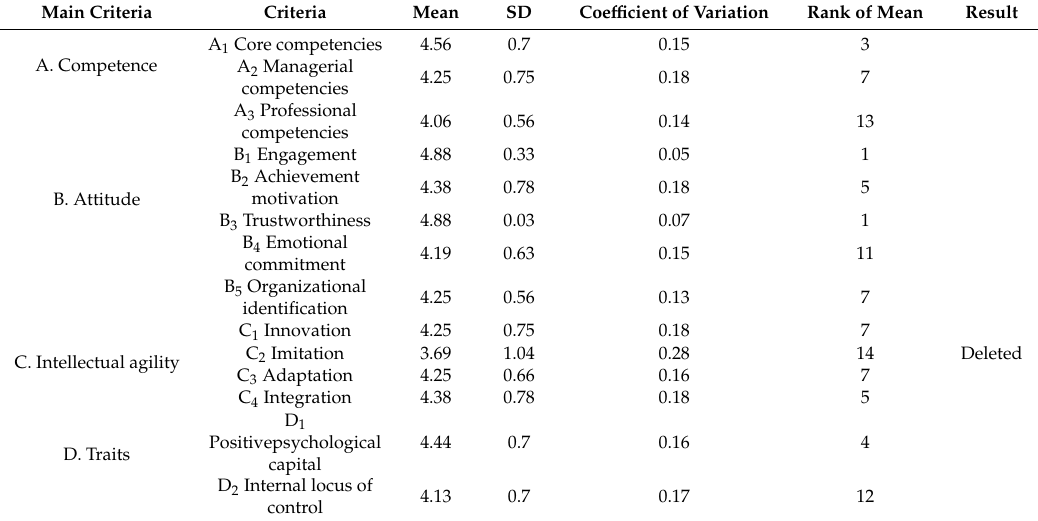
Table 3. Results of modified Delphi